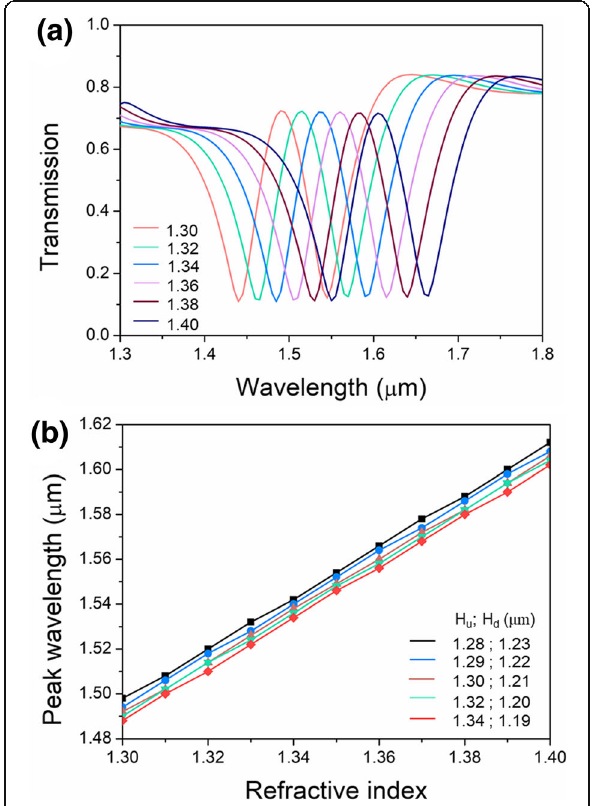
Fig. 5 PIT-based sensing properties. a Transmission spectra of 90-nm height difference for refractive index varying from 80 to 120 nm. b Dependence of peak wavelength on refractive index for different height